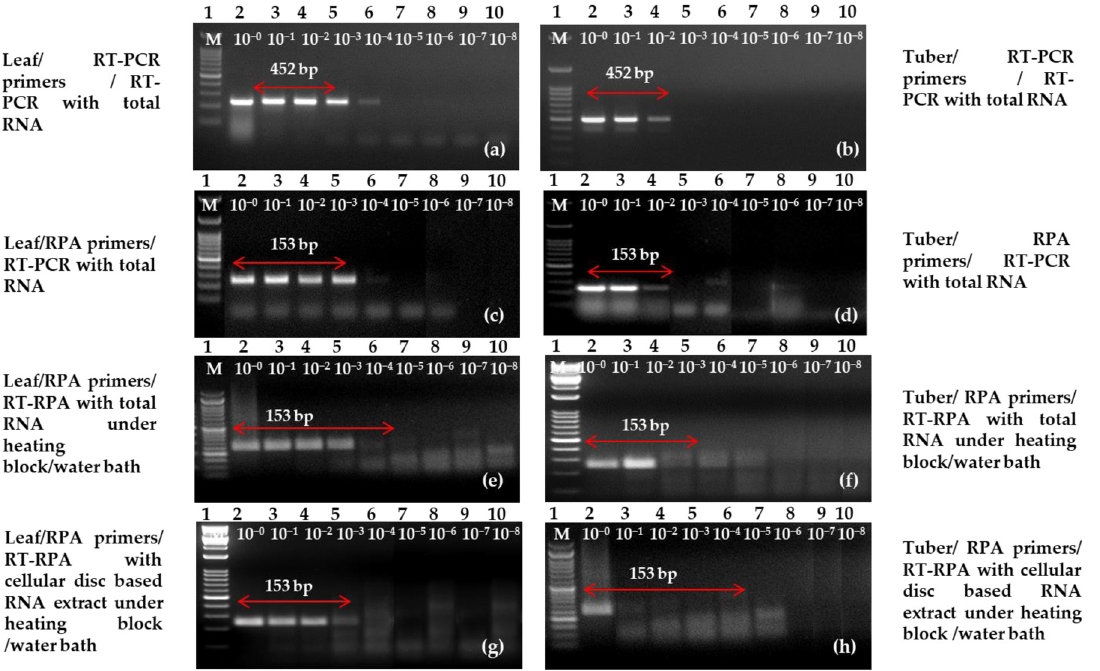
Figure 7. Reverse transcription-polymerase chain reaction (RT-PCR) and reverse transcription- recombinase polymerase amplification (RT-RPA) amplified amplicons at dilutions levels ranging from 10 − 0 to 10 − 8 detect potato leafroll virus (PLRV). One-step RT-PCR with previously reported primers [12] on purified RNA performed with ( a ) infected leaves and ( b ) infected tubers. One-step RT-PCR with optimized primer LRRPAF3/R3 on purified RNA in ( c ) infected leaves and ( d ) infected tubers. One-step RT-RPA with newly optimized primer LRRPAF3/R3 on purified total RNA in ( e ) infected leaves and ( f ) infected tubers. One-step RT-RPA with optimized primer LRRPAF3/R3 on cellular disc-mediated RNA extract in ( g ) infected leaves and ( h ) infected tubers. Lane M ( a – h ): 50 bp DNA